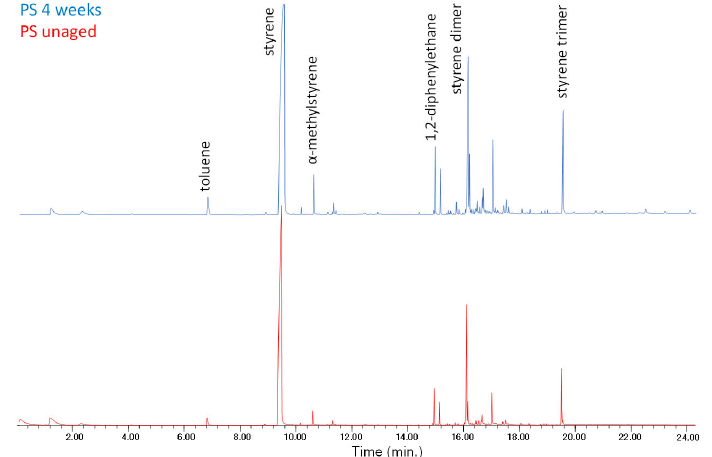
Figure 18. Chromatograms obtained in the Py–GC–MS analysis of the extraction residues of PS-0w (red) and PS-4w (blue). The complete list of the main pyrolysis products is reported in Table S15 in Supplementary Materials.